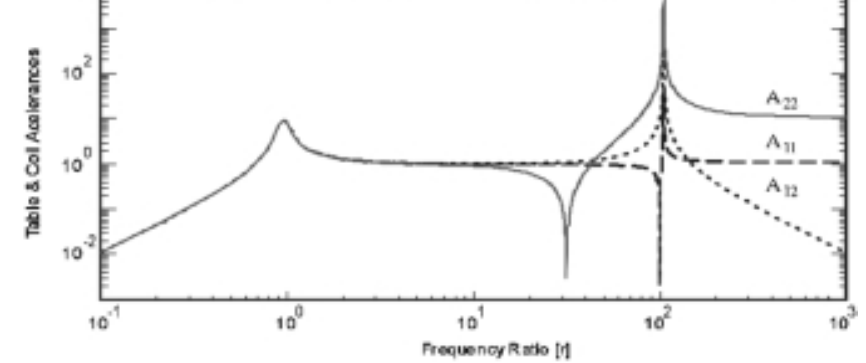
Fig. 2. Dimensionless accelerance plot for exciter